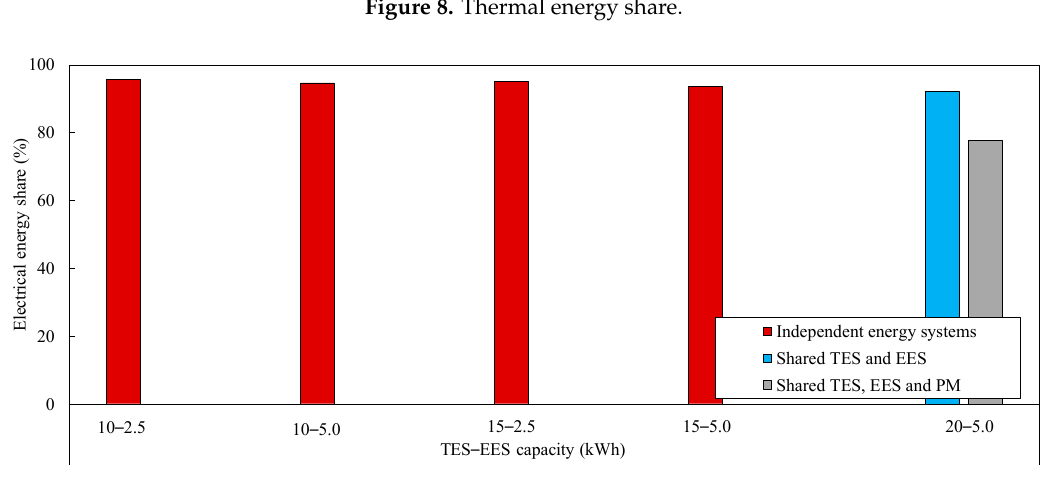
Figure 9. Electrical energy share.